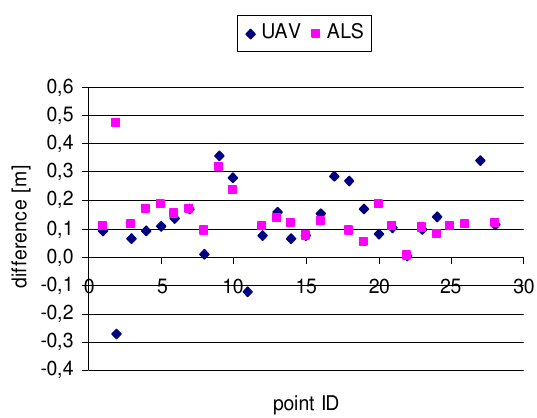
Fig 3.4: Height differences between Check Points located on 3D models and measured by